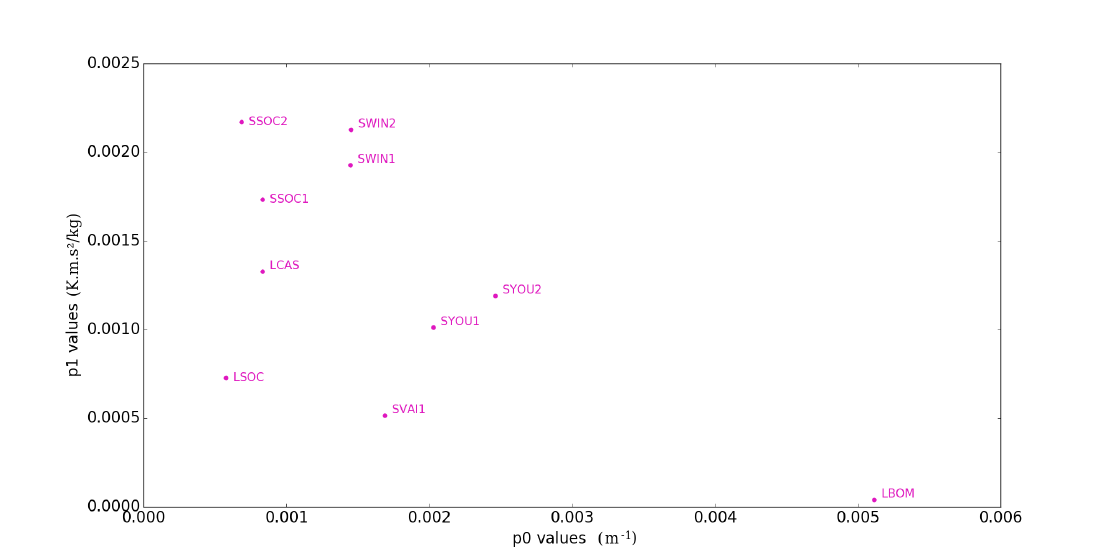
Figure 9. Regression coefficient p 1 versus p 0 coefficient for the entire dataset (2 ◦ ≤ Θ < 90 ◦ ). The dot corresponds to the median value of the regression coefficient. Please note that the root mean square of its median variance over the 50 regressions is low (lower than 2% of the median value).